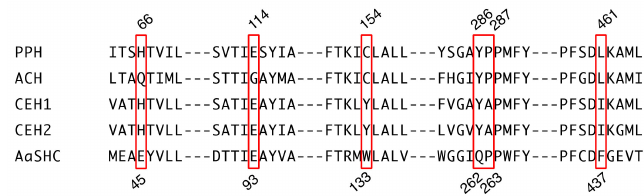
Figure 3. Partial amino acid sequence alignment of hydroxyhopane/hopene synthases. Numbers above the sequence show positions in PPH, and numbers below the sequence show those in AaSHC. Red boxes indicate active site residues, which might influence the final cation elimination